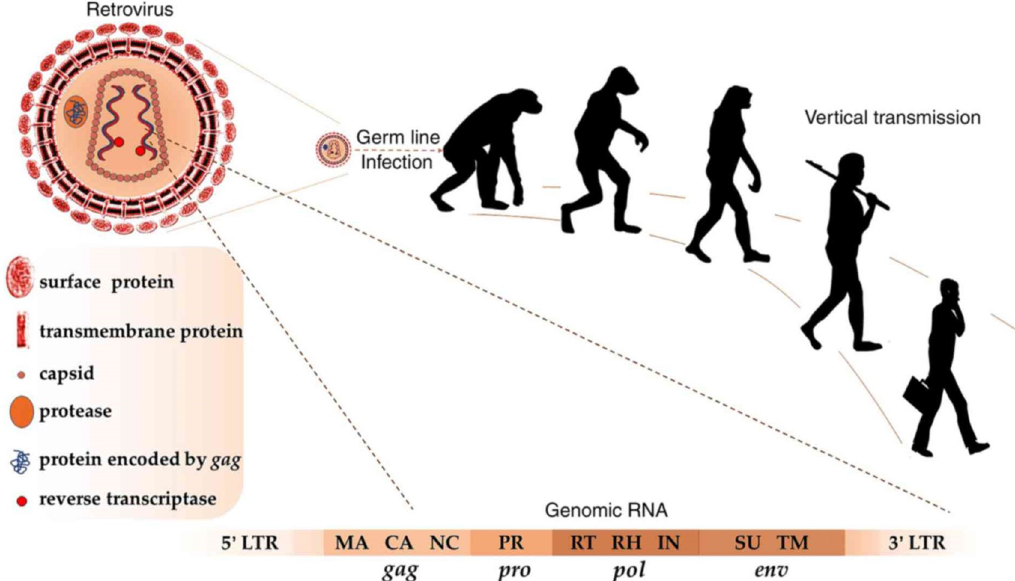
Figure 2. Germ line infection with retroviruses about 25 million years ago resulted in vertical transmission of HERVs in modern humans. As in retroviruses, complete HERV RNA includes the genes gag , pro , pol and env , flanked by 5’ and 3’ LTRs. Matrix (MA), capsid (CA), and nucleocapsid (NC) proteins are encoded by gag ; protease (PR) is encoded by pro ; reverse transcriptase (RT), Ribonuclease H (RH), and integrase (IN) are encoded by pol ; surface (SU) and transmembrane (TM) proteins are encoded by env Note. Reprinted from “Human endogenous retroviruses in cancer: expression, regulation and function,” by Gao Y, Yu XF, Chen T. Oncol Lett. 2021;21:121 (https://doi.org/10.3892/ol.2020.12382). CC